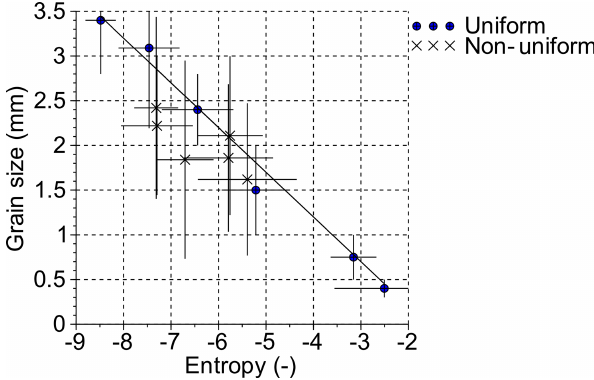
Figure 9. The grain size calibration for uniform and non-uniform samples. Horizontal error bars are the entropy standard deviation of the sample and the vertical bars are the grain size sieving